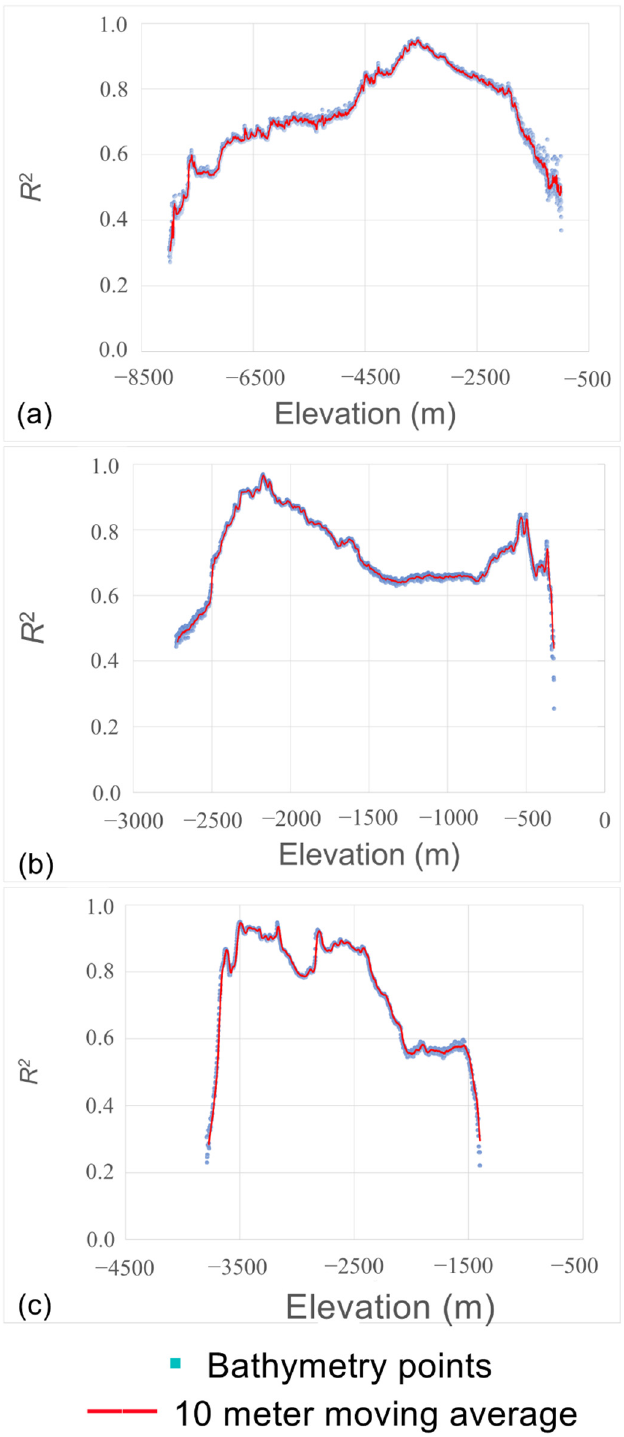
Figure 6. Relationship between water depth and precision ( R 2 ) in ( a ) West Pacific, ( b ) Southern Ocean, and ( c ) East Pacific.